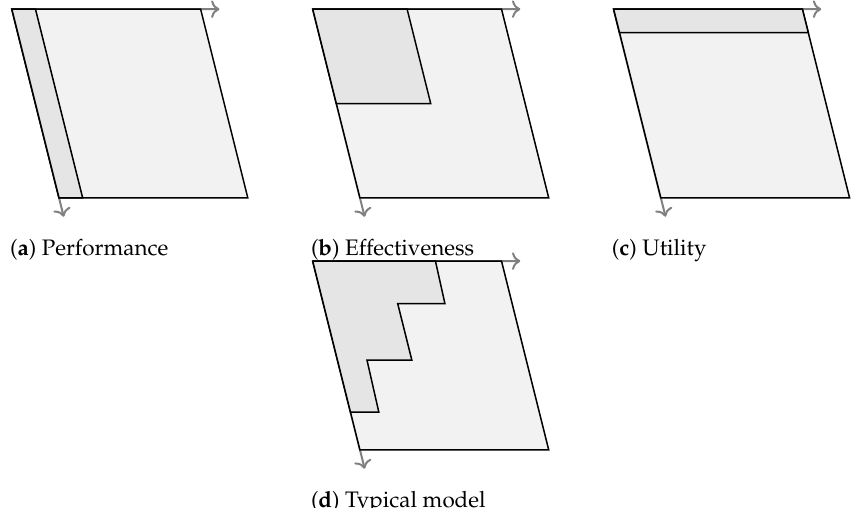
Figure 3. An archetypal performance model has high resolution and limited scope, whereas an archetypal utility model has wide scope and low resolution. A typical simulation model often emphasizes resolution in a particular area of concern, makes simplifying assumptions and implements sufficient abstractions for other areas still within scope, and assumes away other areas as out of